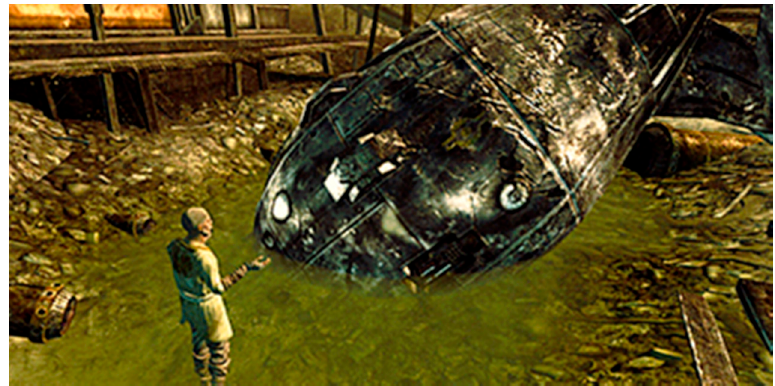
Figure 1. Confessor Cromwell preaching and praying next to the atom bomb.